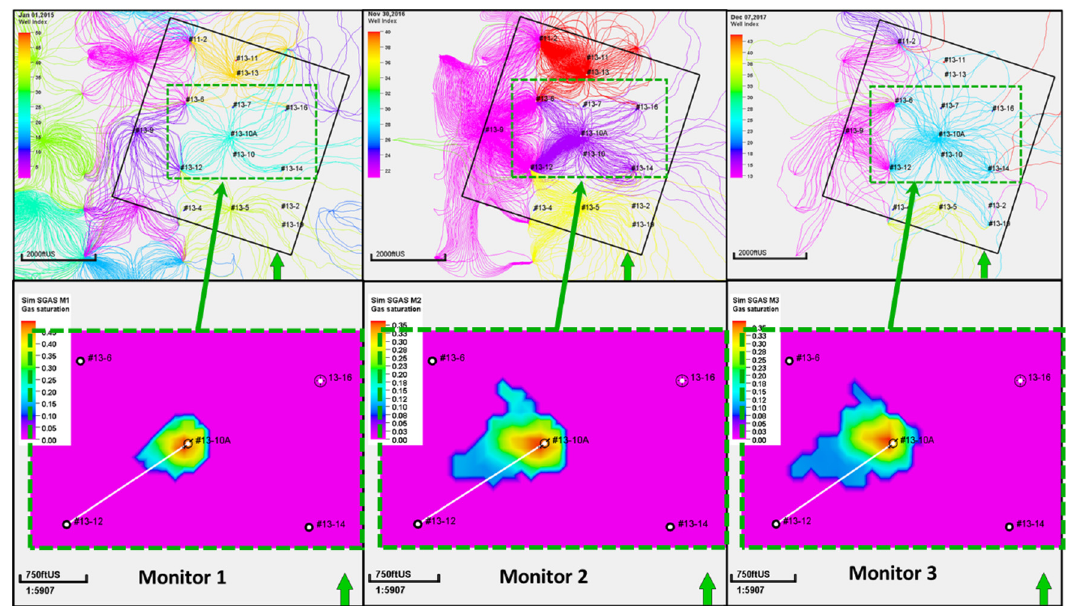
Figure 11. Streamlines ( top ) and compositional simulations of CO 2 saturation ( bottom ) in the 13-10A pattern at monitor survey times.